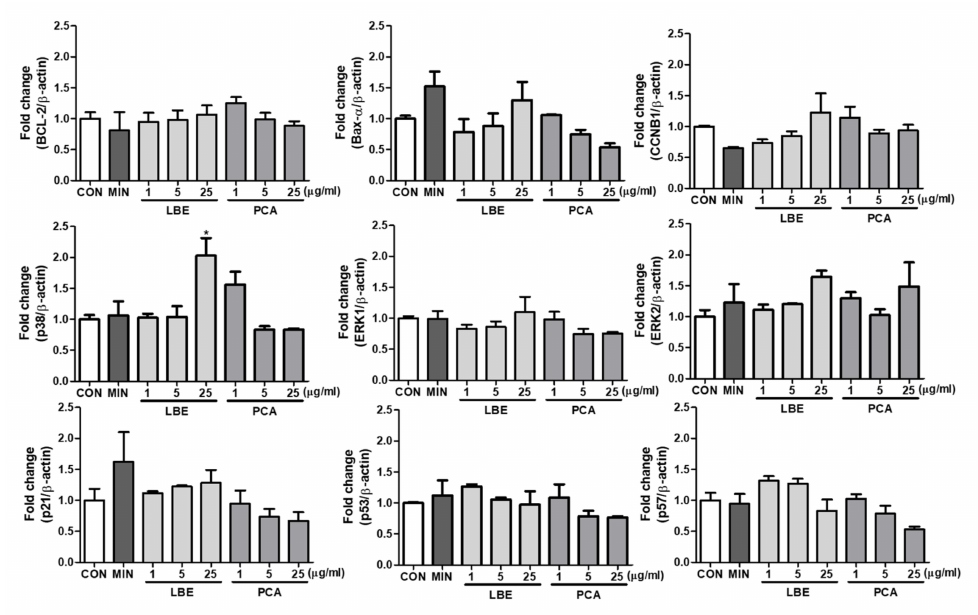
Figure 6. qRT-PCR analysis of genes related to cell cycle arrest (ERK, p21, p53), differentiation (p38), mitosis (CCNB1), proliferation (p57), and apoptosis (Bax, Bcl-2) after 60 h of treatment of human dermal papilla cells with LBE, PCA, and minoxidil. Representative data from each group are expressed as means ± SDs ( n = 3). * p < 0.05 compared with the control